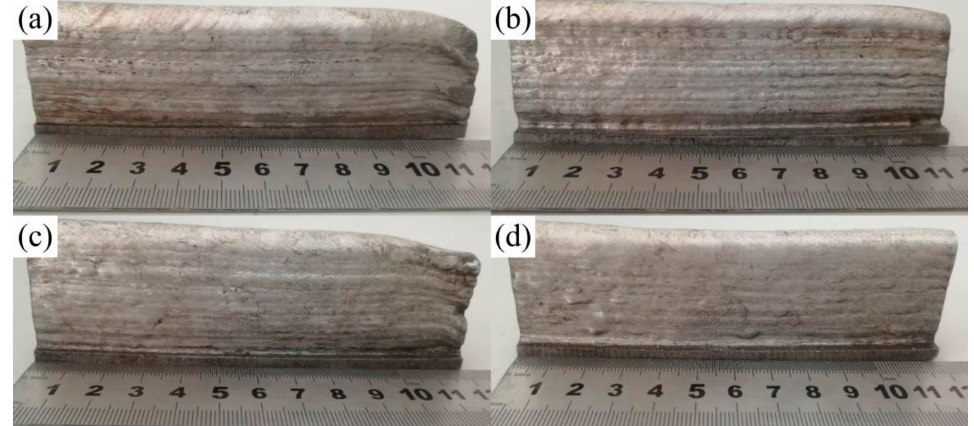
Figure 6. Macromorphology of deposited specimens with different processing. ( a ) Deposition specimen with constant heat input and inter-layer cooling (Specimen A). ( b ) Deposition specimen with inter-layer cooling (Specimen B). ( c ) Deposition specimen with welding current for each layer reduced by 2 A (Specimen C). ( d ) Specimen with proposed deposition process (Specimen D).